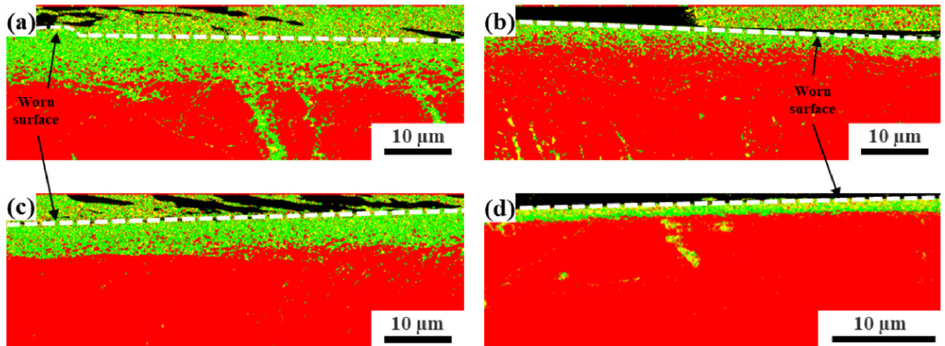
Figure 7. EBSD analysis of cross-sectioned AISI304 blocks after wear tests: phase maps of blocks at rotation speeds of ( a ) 100 and ( b ) 300 rpm obtained from tests under dry contacts, ( c ) 300 rpm obtained from tests under water-lubricated contacts, and ( d ) 300 rpm obtained from tests under oil-lubricated contacts.